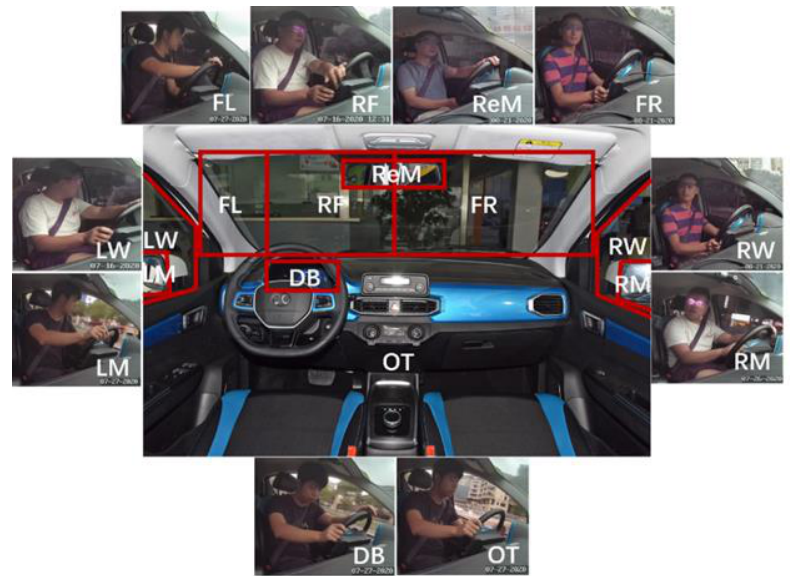
Figure 4. The specific locations of AOIs determined by the drivers’ views and the corresponding photographs. RF refers to right front, FL refers to front-left, FR refers to front-right, LW refers to left window, LM refers to left mirror, RW refers to right window, RM refers to right mirror, ReM refers to rearview mirror, DB refers to dashboard and OT refers to others.